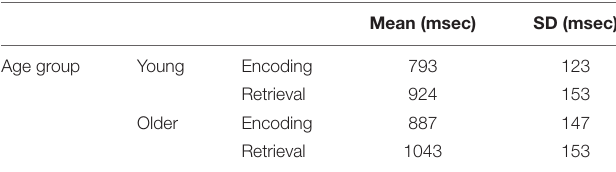
TABLE 2 | Means and standard deviations of reaction times in the different tasks in Phase